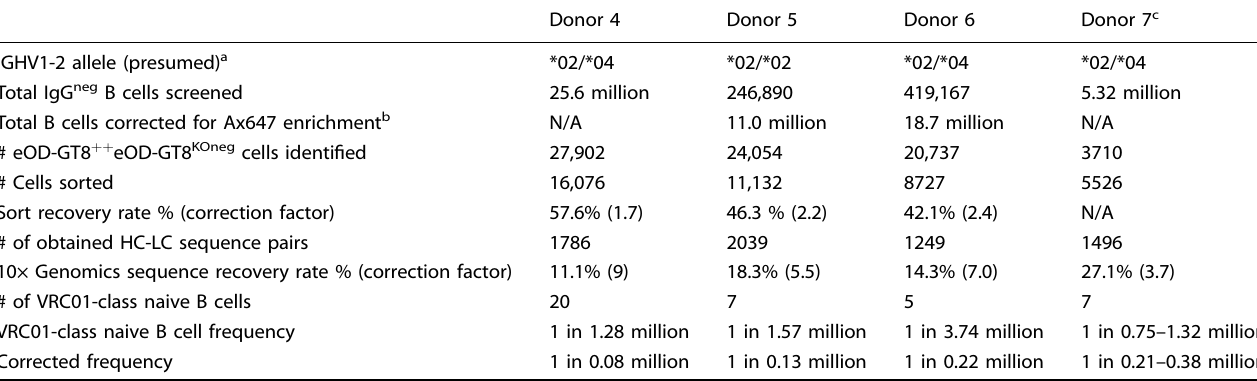
Table 3. VRC01-class naive B cell precursor frequency calculated for cells sorted with